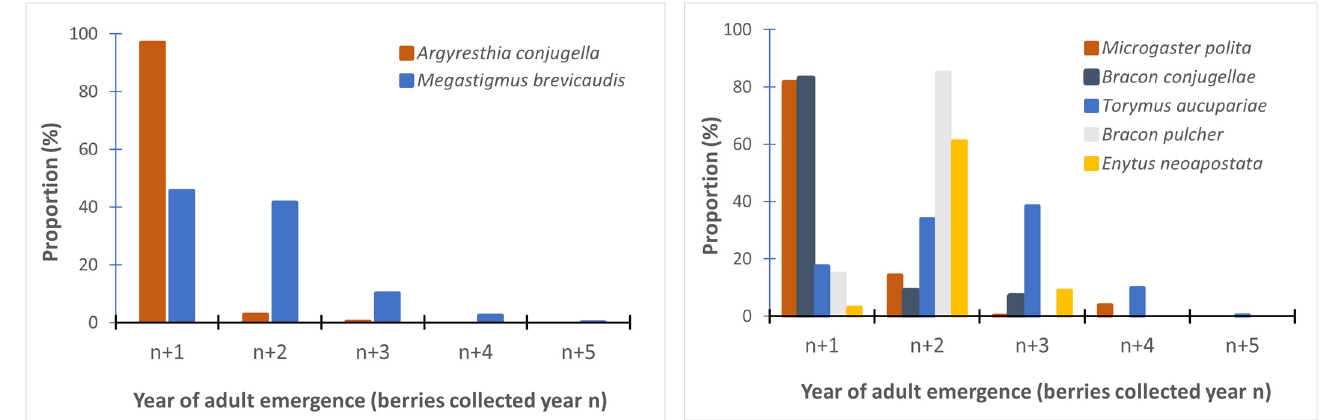
Figure 4. Relative annual emergence of adults for each of the insect species exhibiting delayed emergence from the rowanberry samples kept for fi ve years. Pooled data for berries collected 1978–1984; species sorted by proportion emergence in year n + 1: ( a ) The two seed predators. ( b ) The fi ve parasitoids.